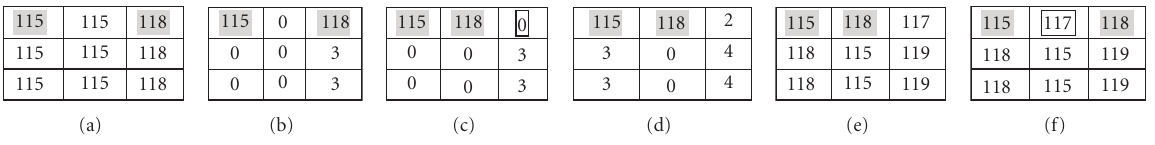
Figure 1: Example of data embedment with an input data digits of (103 103 2) 4 . (a) A host block, (b) a di ff erence block; (c) adjust the maximum pixel value (118) to the top-left of the block; (d) add each data digit to the coe ffi cients of the block in reverse order, (e) a hidden block, and (f) the resultant stego-block 2.